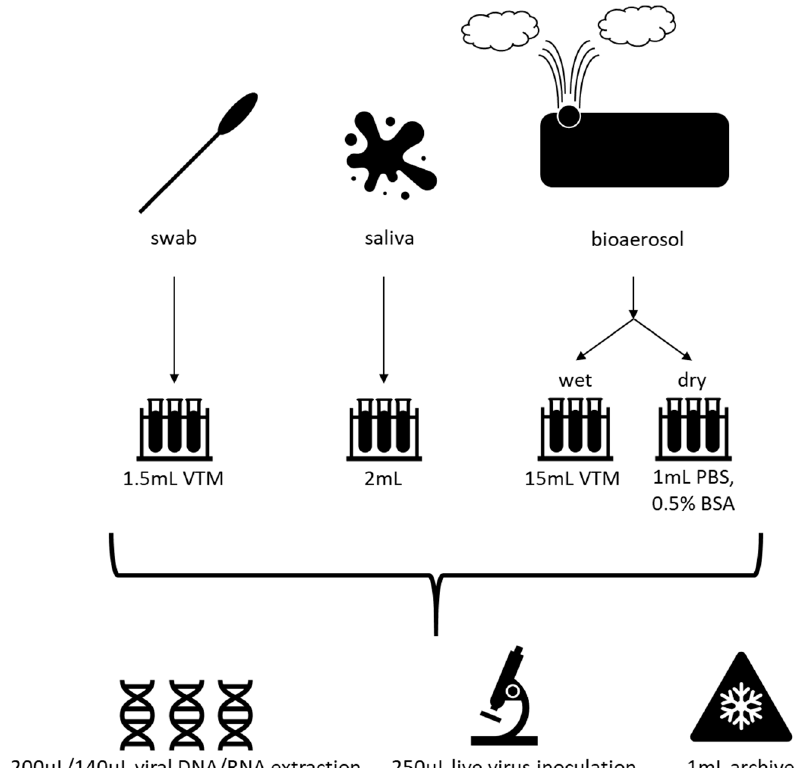
Figure 4. Sample processing workflow. Swab samples are collected in 1.5 mL viral transport media (VTM), 2 mL of saliva is collected as-is, and bioaerosol samples are collected in a wet stage (15 mL VTM) or a dry stage, which is then suspended in 1 mL phosphate-buffered saline (PBS) with 0.5% bovine serum albumin (BSA). Subsequently, these samples are divided for DNA/RNA extraction, inoculation in cell culture to obtain live virus, or stored as an archival sample at − 80 °C .